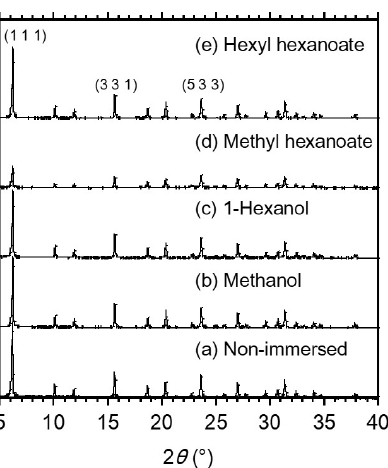
Figure 4. XRD pattens of the FAU-powder after immersion treatments in ( a ) non-immersed reference ( b ) methanol, ( c ) 1-hexanol, ( d ) methyl hexanoate, and ( e ) hexyl hexanoate.